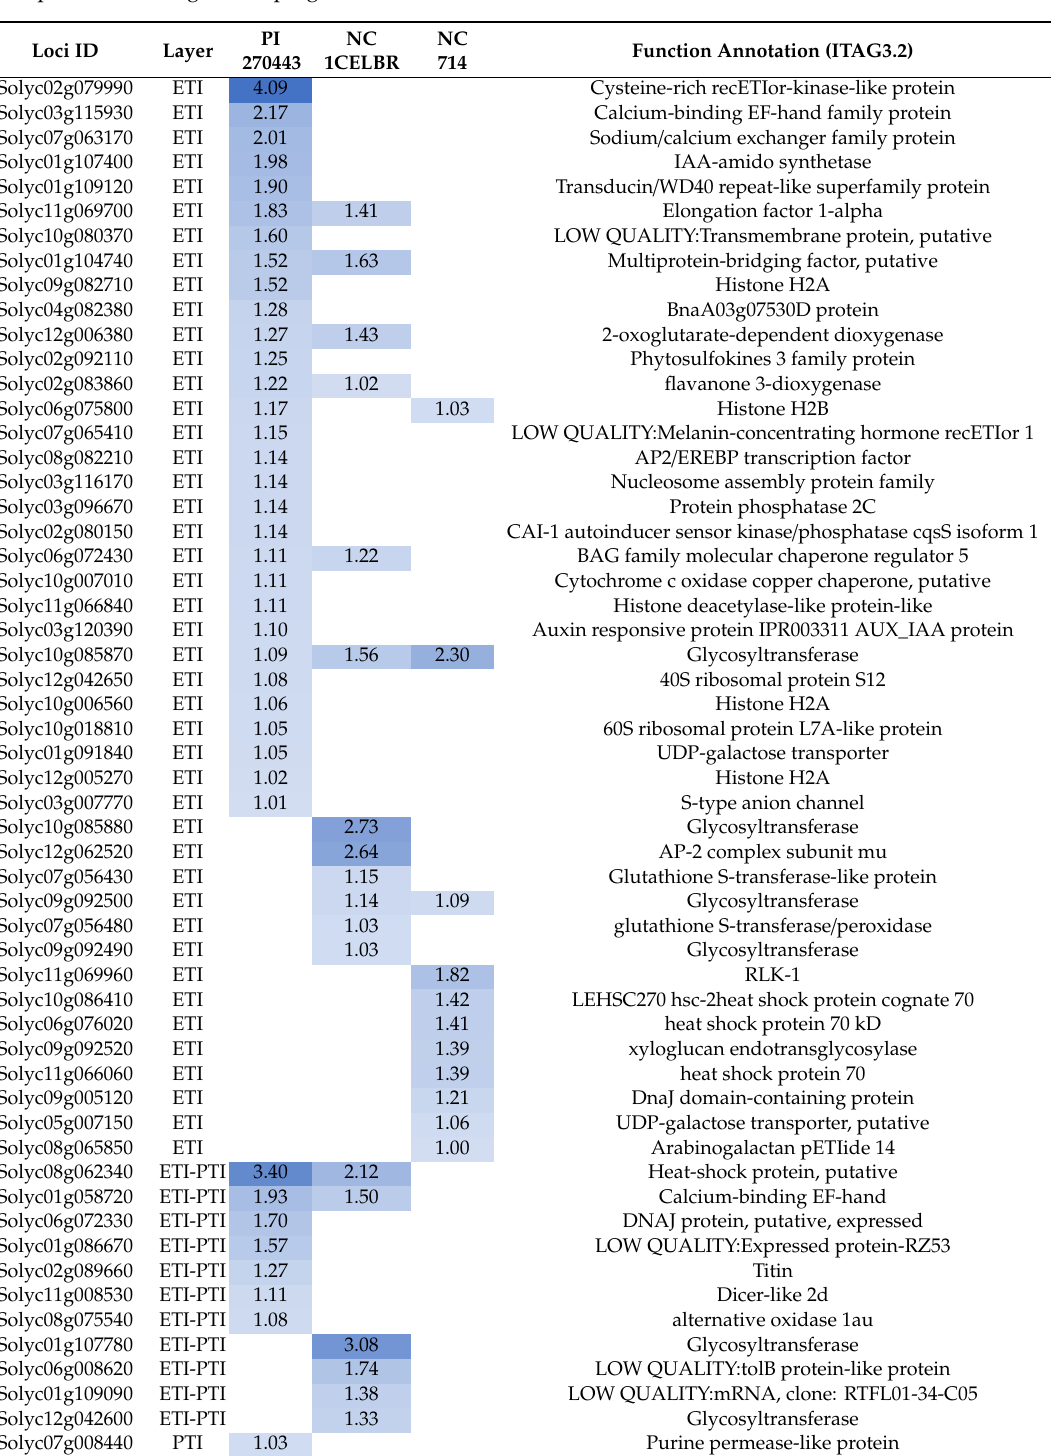
Table 4. E ff ector-triggered immunity (ETI) and pattern-triggered immunity (PTI)-associated genes among BS-induced upregulated DEGs. DEG expression change listed as (log2) between inoculated and control samples underlines PI270443, NC 1CELBR, and NC714. The intensity of the blue background represents the degree of